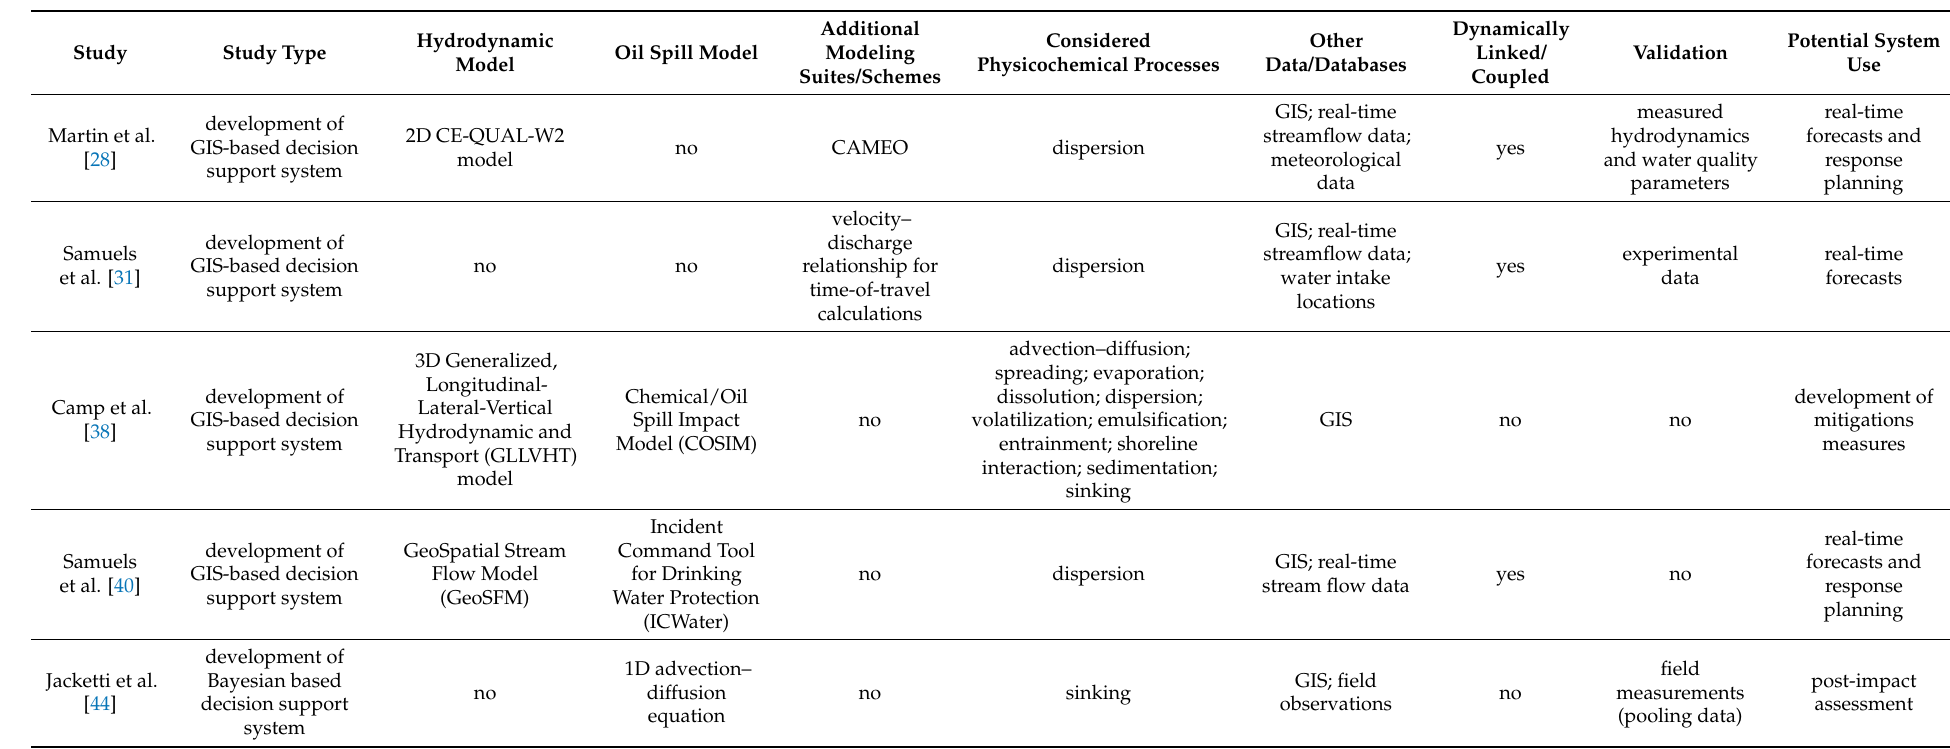
Table 2. Development of decision support